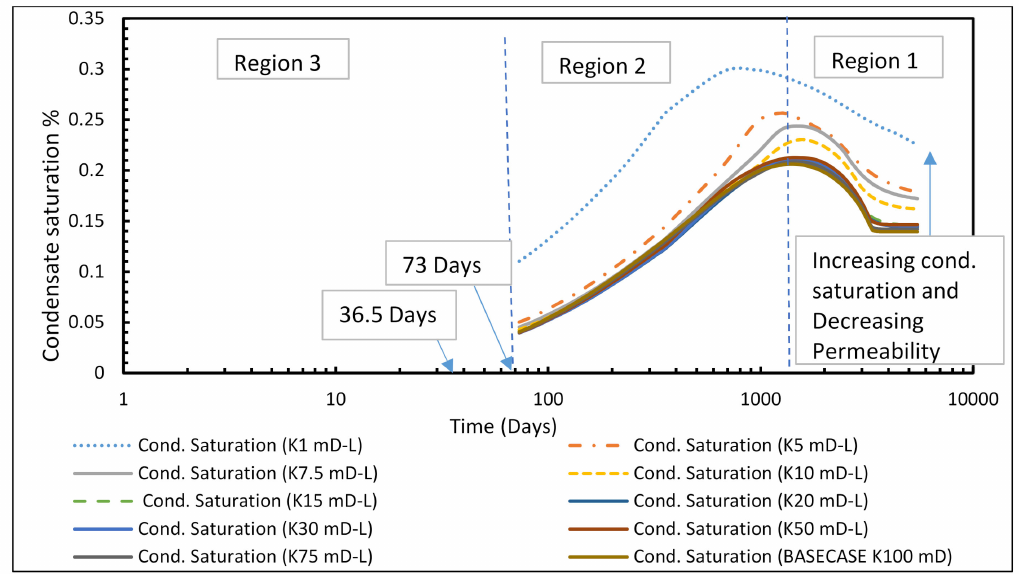
Figure 5. Condensate saturation as a function of time at the wellbore for di ff erent permeabilities: local